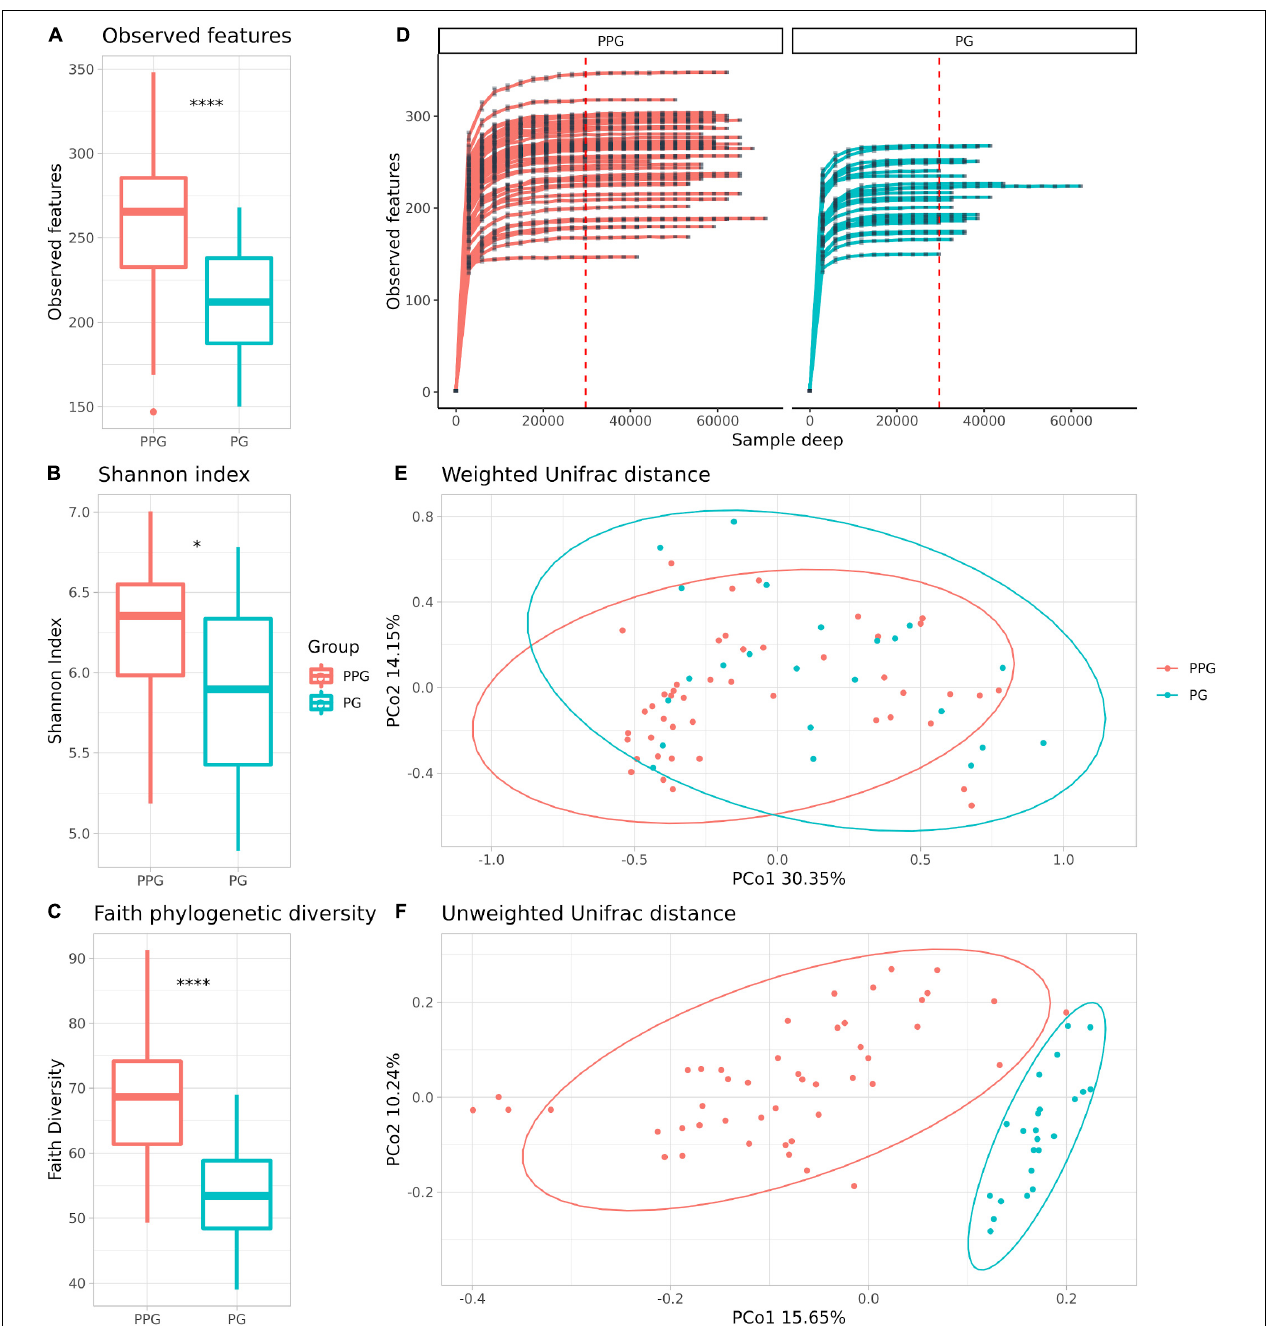
FIGURE 1 | Comparison of the microbiome community of PPG and PG groups. Alpha Diversity measures: Observed features (A) , Shannon index on a base-2 logarithmic scale (B) and Faith phylogenetic diversity (C) . ∗ p = 0.026; ∗∗∗∗ p < 0.001. Rarefaction curves of the samples from the PPG and PG (D) . The x axis represents the number of sequences sampled while the y axis represents a measure of the species richness detected (estimated number of observed features). The red vertical dotted line represents the rarefaction depth chosen (sample with the least amount of sequences). PCoA plots of beta diversity with weighted (E) and unweighted (F) UniFrac distances, respectively. Ellipses represent the 95% confidence interval of each group. Colors are assigned by group, red for PPG and blue for